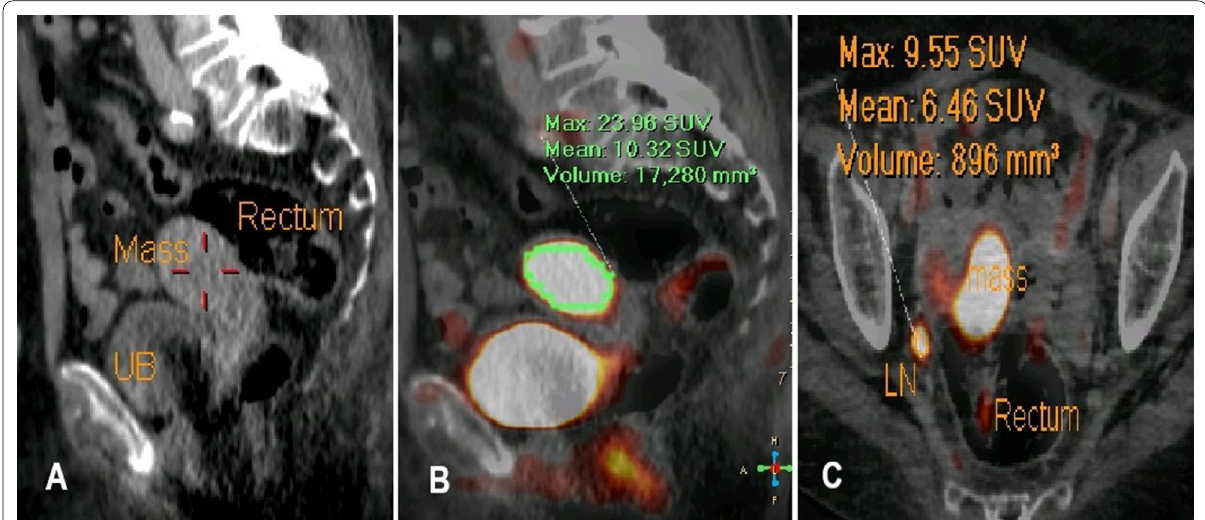
Fig. 3 A large hypermetabolic endometrial soft tissue thickening [image A ], mainly involving the left lateral aspect of the endometrium, measuring 36 30 41mm at its maximal AP, TR & CC dimensions having intense avidity for FDG uptake [23.9 SUV max , SUV mean 10.32 and ± × × MTV 17,280 mm 3 ], on corresponding PET image [image B ]. Associated infiltration of more than 50% of the myometrial coat yet no associated = extra uterine or parametrial extensions. Regional solitary right internal iliac LN is noted about 13 C ], 9.5 SUV max, 6.46 SUVmean and vol. 896 mm =